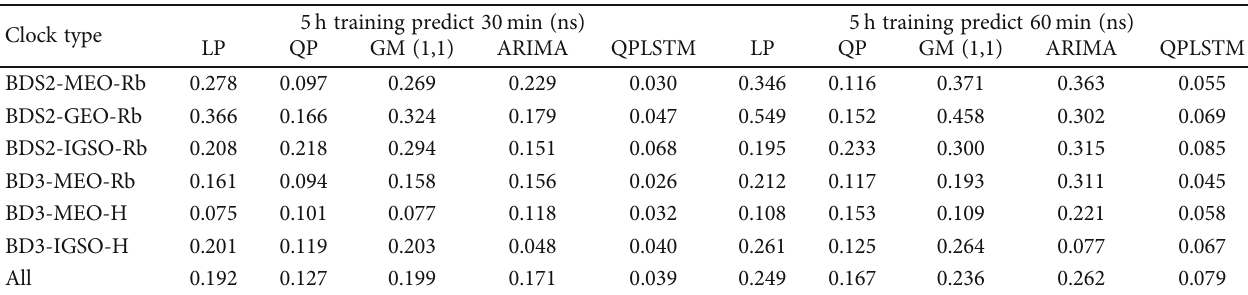
Table 5: 30 min and 60min average prediction RMSE for six di ff erent clock categories based on the fi ve models for 24 h. Clock type